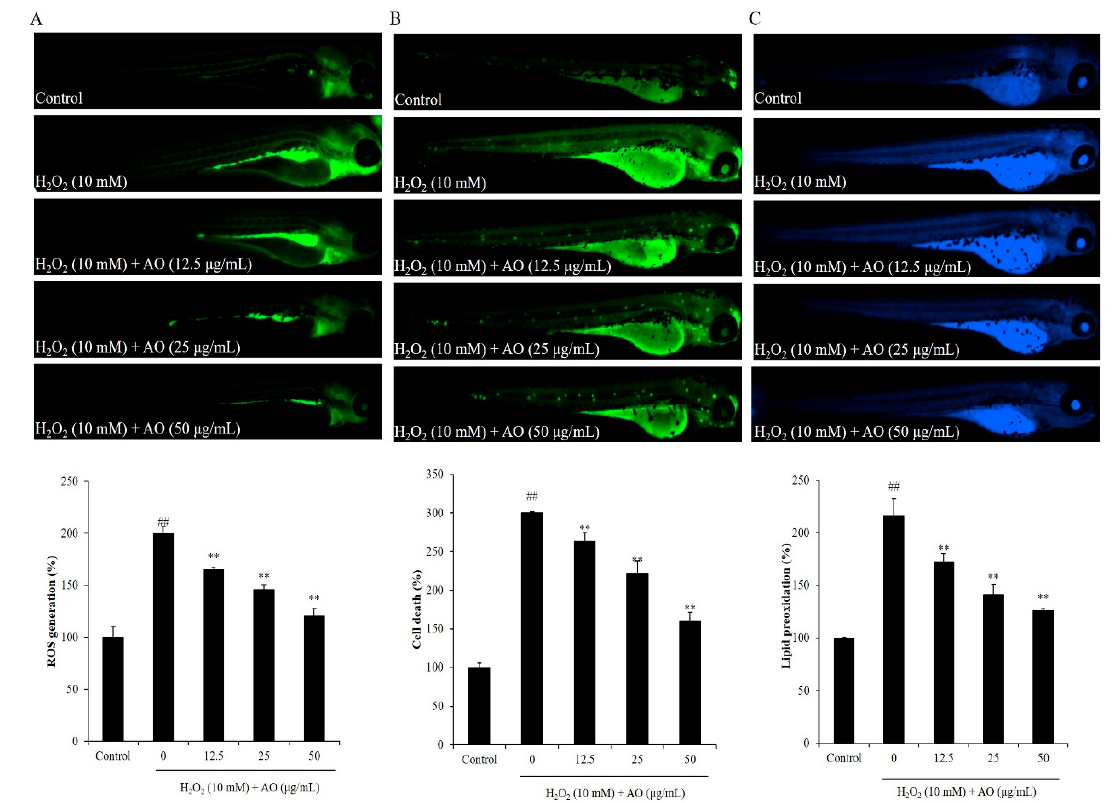
Figure 4. The effect of AO on H 2 O 2 -stimulated oxidative stress in zebrafish. ( A ) The protective effect of AO against H 2 O 2 -stimulated ROS production; ( B ) the protective effect of AO against H 2 O 2 -stimulated cell death; ( C ) the protective effect of AO against H 2 O 2 -stimulated lipid peroxidation. ## p < 0.01 as compared to the control group. ** p < 0.01 as compared to the H 2 O 2 -treated group.